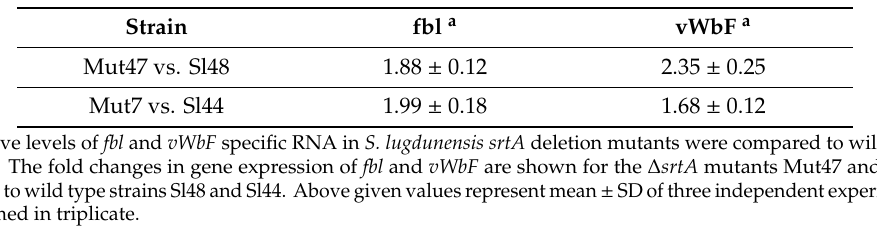
Table 4. Real-time quantification of fbl and vWbF